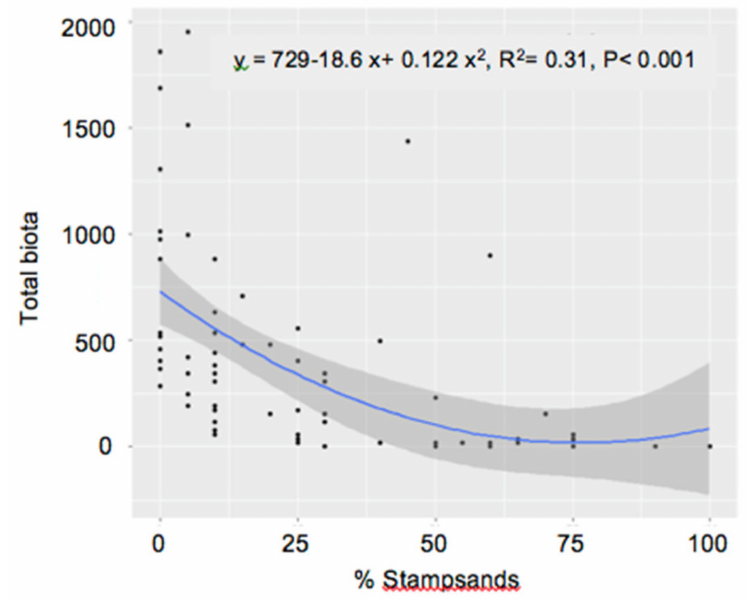
Figure 13. Second degree polynomial regression fit for total macroinvertebrate density versus percentage stamp sands. Equation is given above, with R 2 and probability. Notice that above 75% SS, there were almost no organisms. Darkened region around regression is 95% C.L.